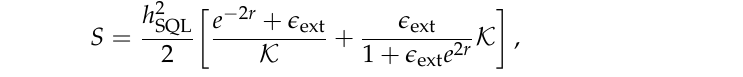
9dB squeezing is ∼